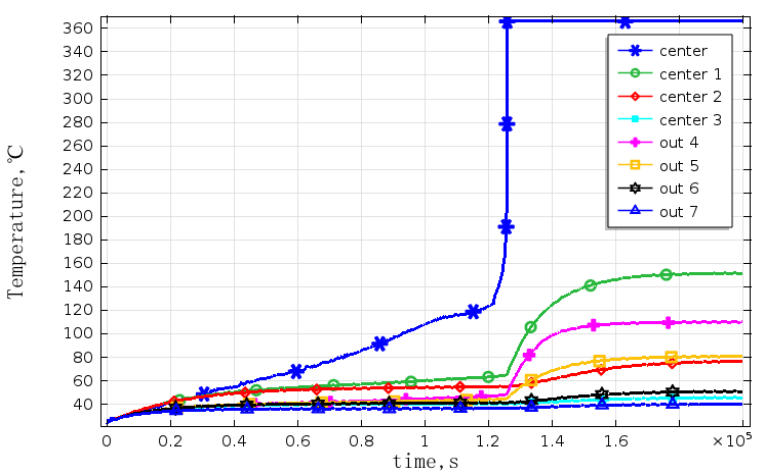
Figure 10. The temperature curves of the battery module under natural convection.